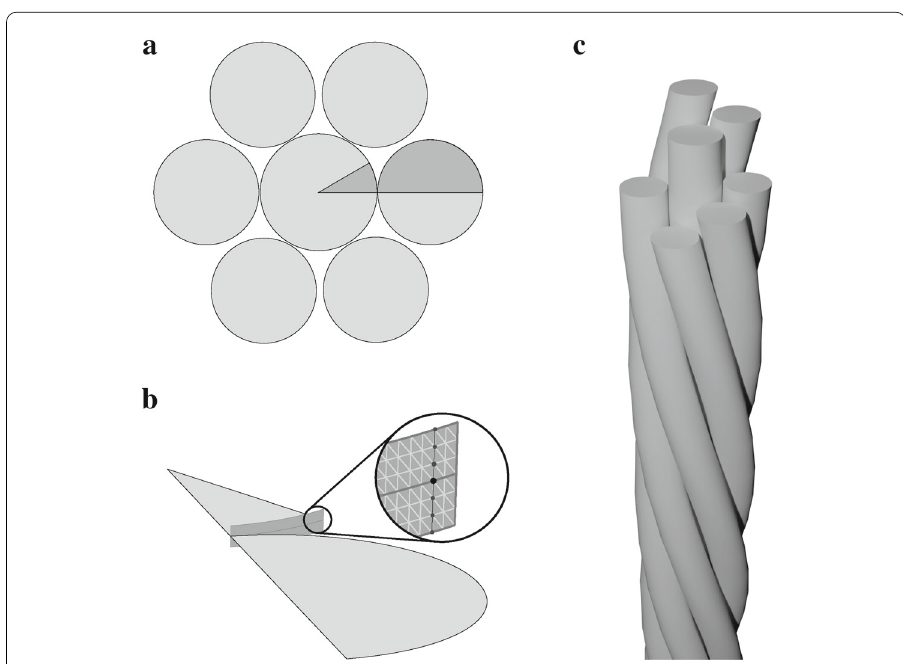
Fig. 5 a Cross section of the 1+6 strand, with highlighted reduced model domain. b Auxiliary surface for contact definition. Nodal degrees of freedom are fully constrained to the corresponding node lying on the original cross section by constraint equations. c Extruded strand, corresponding to the cross section foundin